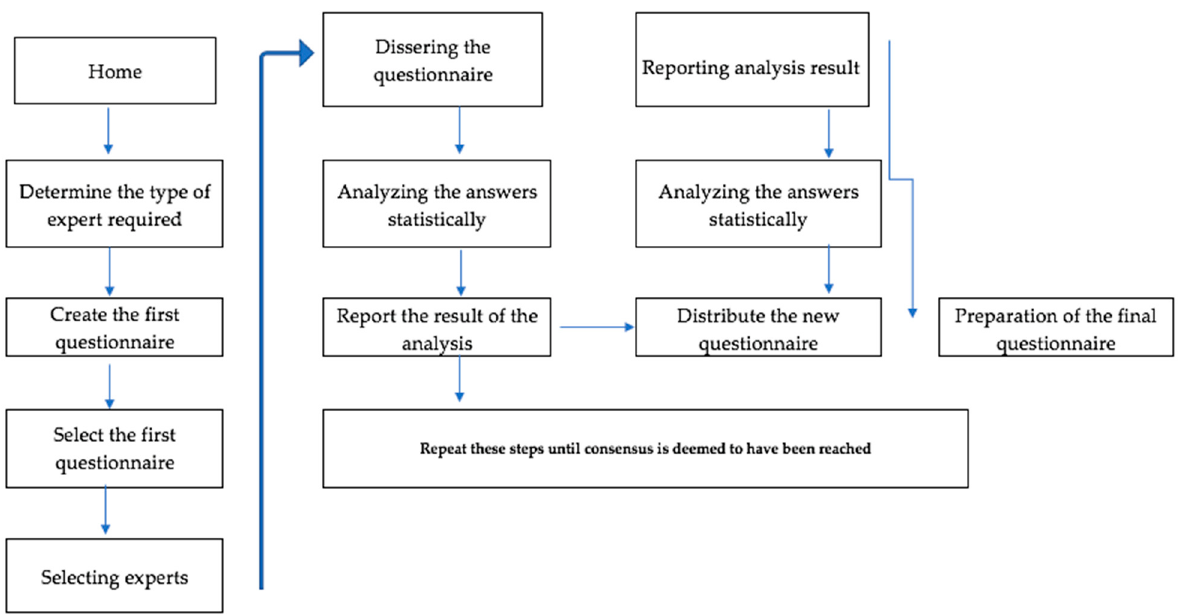
Figure 1. The Delphi Method procedure.